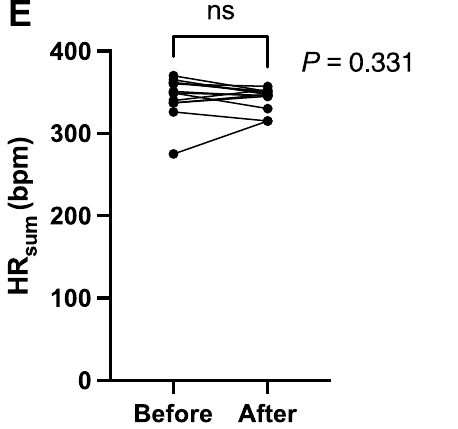
Figure 2. Effect of 6 weeks of multi-component training for ( A ) Throws, ( B ): Special Wrestling Fitness Test index (SWFT index ) , ( C ) HR final (heart rate at the end of the SWFT), ( D ) HR 1min (heart rate at 1-min post SWFT), ( E ) HR sum (sum of HR final and HR 1min ), *: Statistically significant differences ( P ≤ 0.05), ns: Not statistically significant.